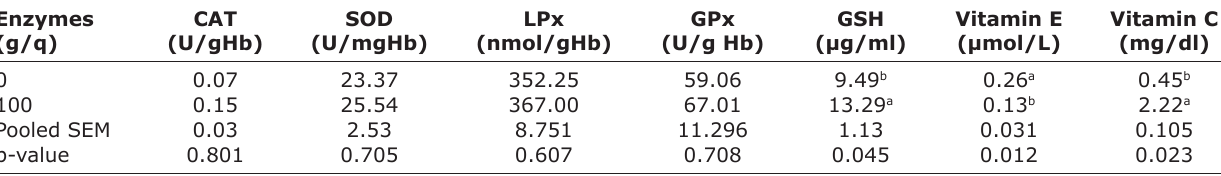
Table-8: Effect of feeding different levels of enzymes on the antioxidant status of blood in broiler. Enzymes (g/q)